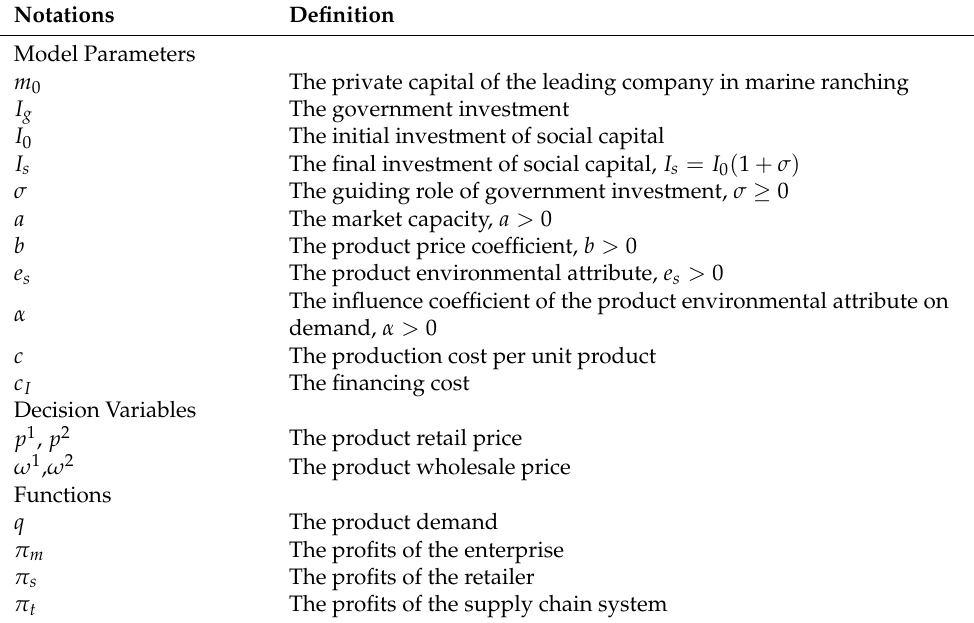
Table 1. List of